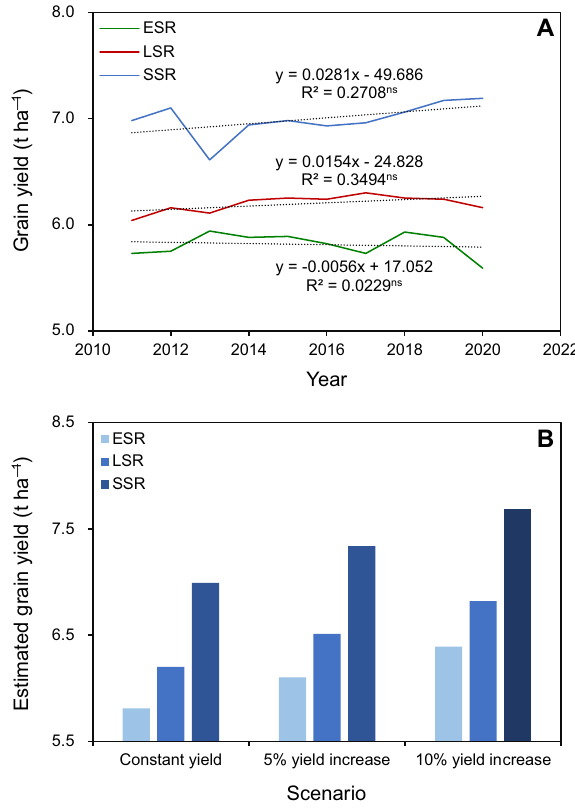
Figure 2. ( A ) Grain yields from 2011 to 2020 and ( B ) estimated grain yields by 2030 under three scenarios for early-season rice (ESR), late-season rice (LSR), and single-season rice (SSR) in the Hunan-Jiangxi region. The grain yields from 2011 to 2020 were calculated based on data collected from the Hunan Provincial Bureau of Statistics 8 and the Jiangxi Provincial Bureau of Statistics 9 . In ( A ), ns denotes non-significant trend at the 0.05 probability level (Statistix 8.0, Analytical software, Tallahassee, FL, USA). In ( B ), the baseline yield for all three scenarios is the average grain yields during